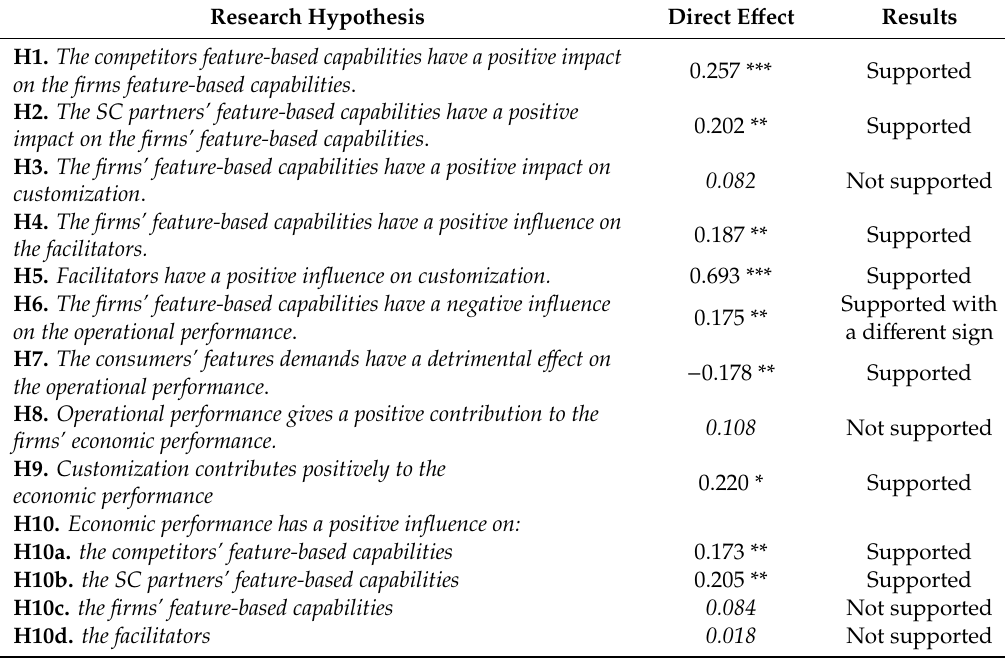
Table 4. Results of the research